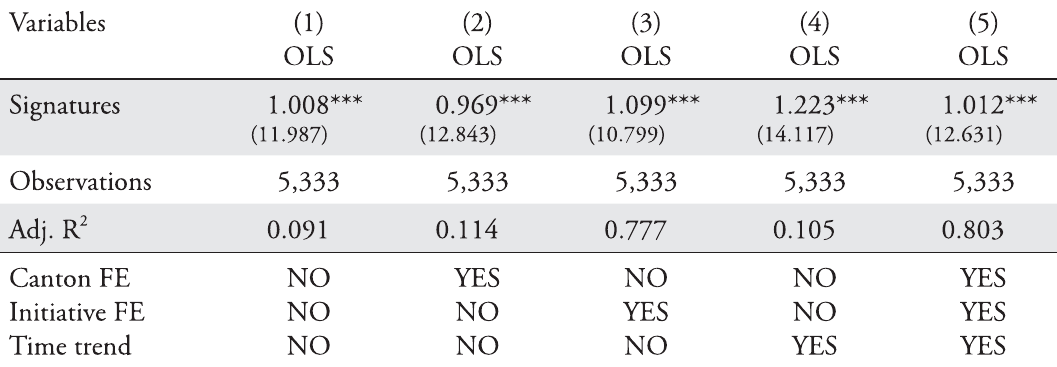
Table 6: Effect of Initiative Signing on Acceptance -Wild Cluster Bootstrap Variables